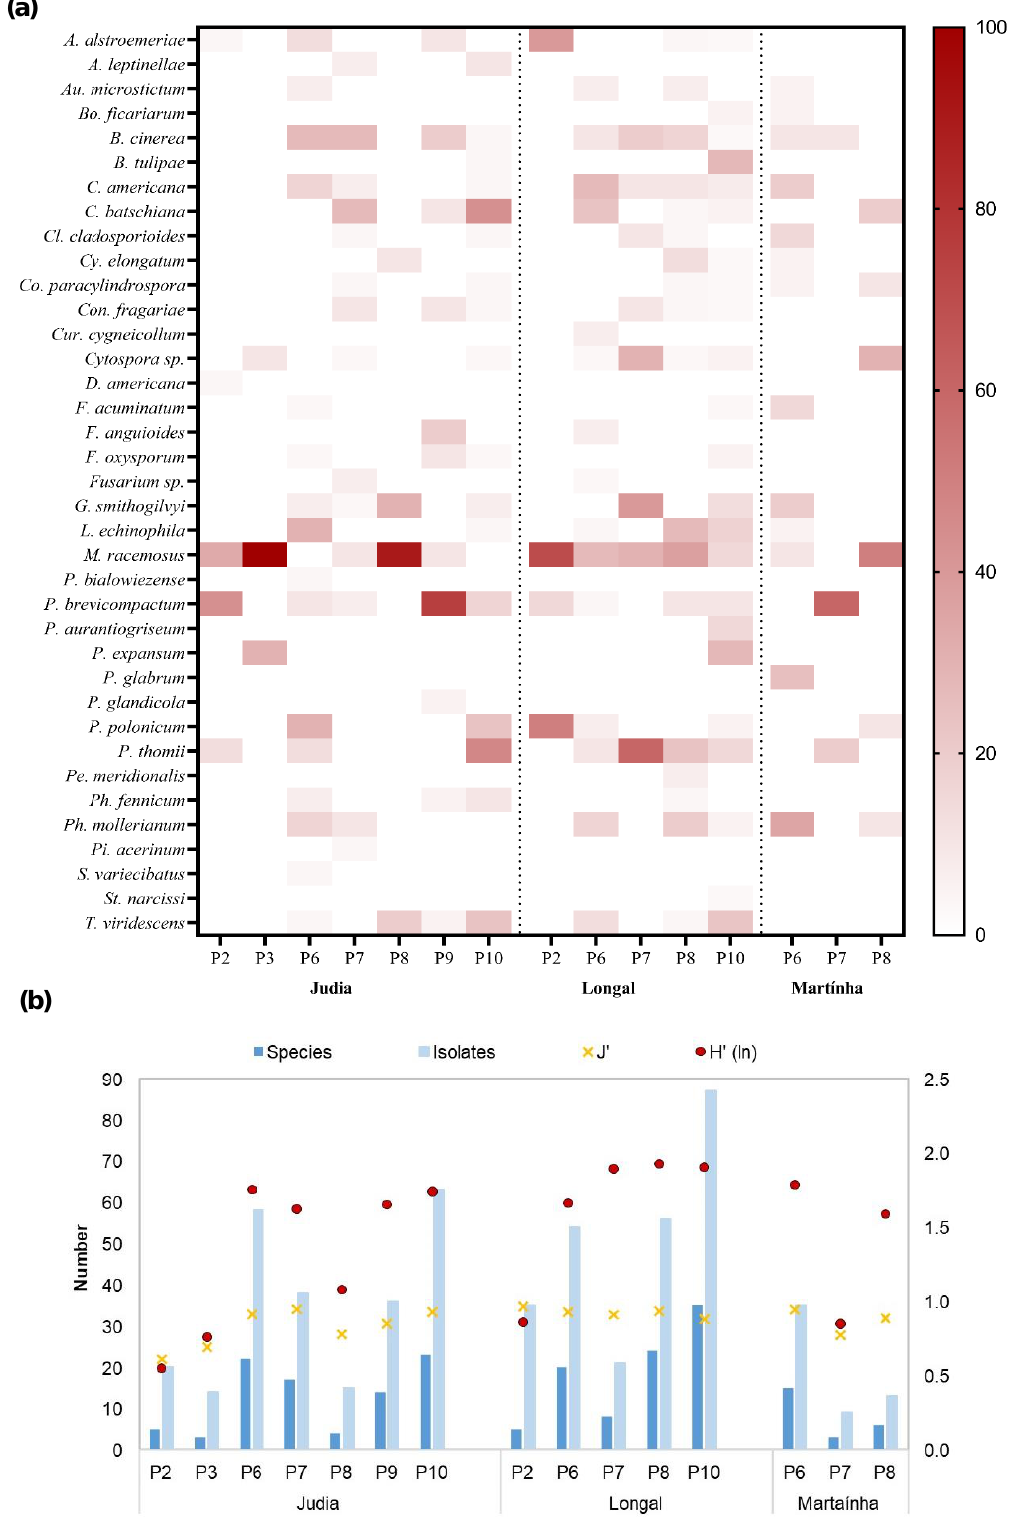
Figure 5. ( a ) Heat map of the frequency of the fungal species (in percentage of analyzed chestnuts), obtained for each storage and processing stages of the Judia, Longal and Marta í nha varieties; ( b ) their respective total number of isolates and species, and diversity indexes (Shannon–Wiener, H’, and Pielou,